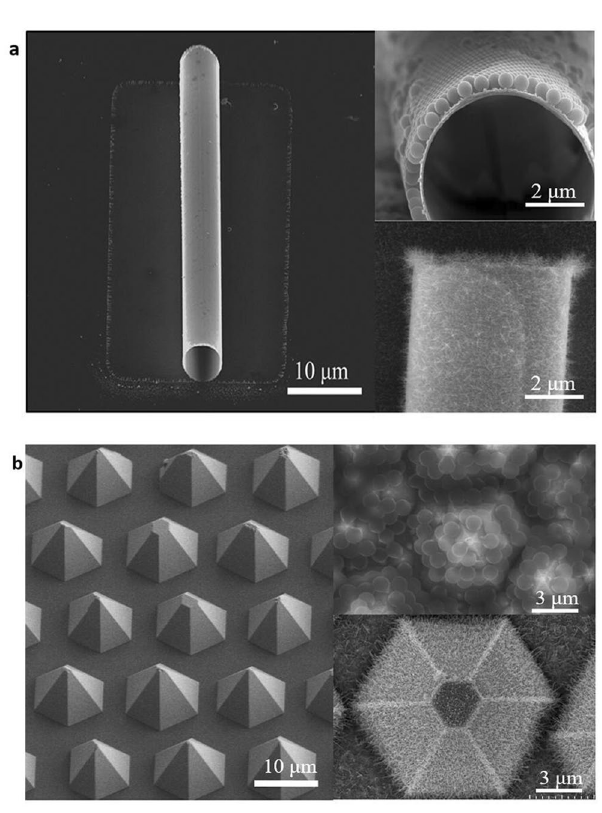
Figure 5. ITO nanowire networks as transparent conductive layer for micro-tube and pyramid. ( a ) The PS spheres can be spread well along the wall of GaN/InGaN micro-tube, and the ITO nanowire networks were fabricated. All the outer wall of the tube was wrapped by nanowires. ( b ) The micro-pyramid array can be covered by ITO nanowire networks without any